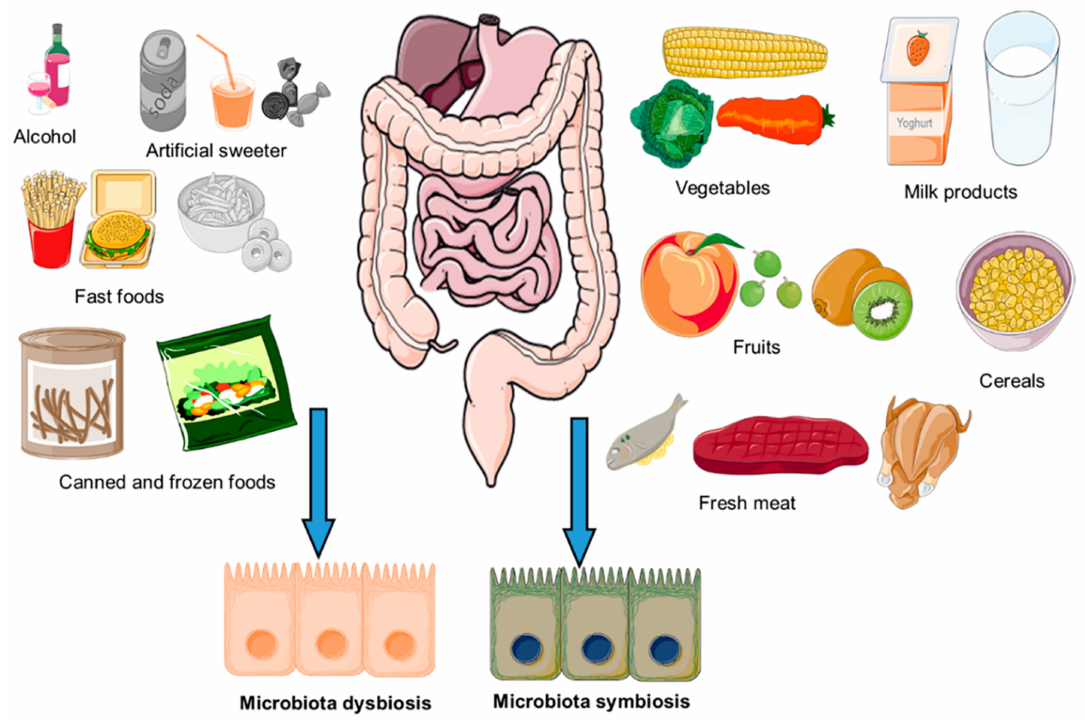
Figure 2. Dietary components that may affect the composition of microbiota leading to the gut symbiosis or dysbiosis. The image was created by using the service provide by Servier Medical Art under license Creative Common Attribution 3.0